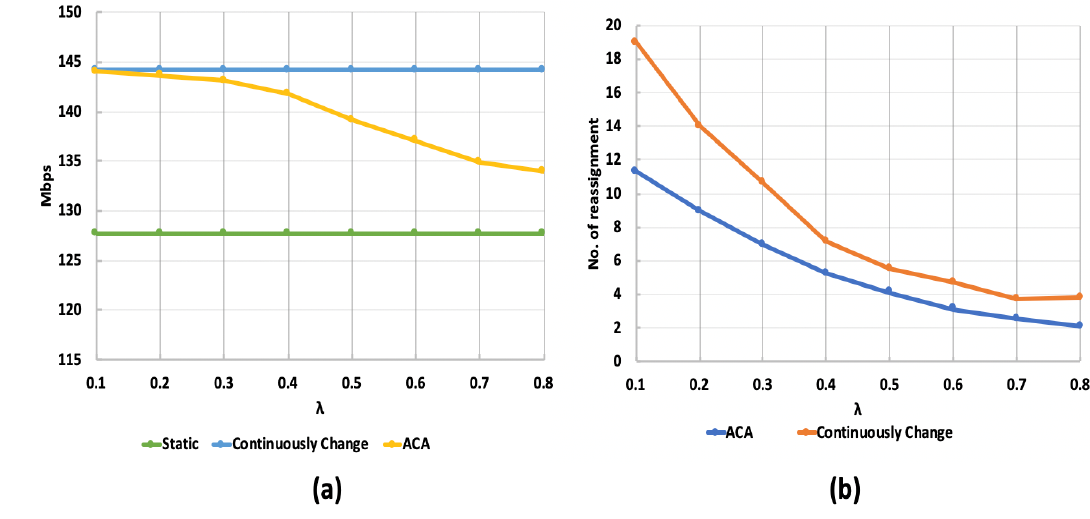
Figure 4. The network topology 1 results, the number of channel reassignments, and the overall throughput with the maximum two NICs, ( a ) throughput comparisons and ( b ) channel reassignment